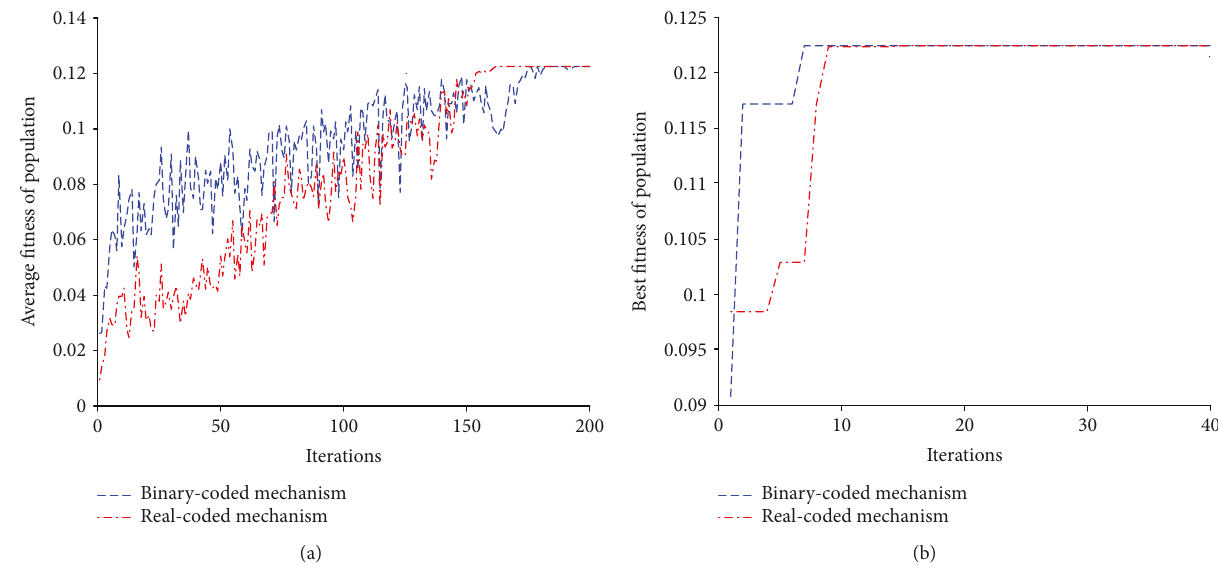
Figure 4: Convergence of the genetic algorithm: (a) the history of average fi tness of population; (b) the history of best fi tness of population.